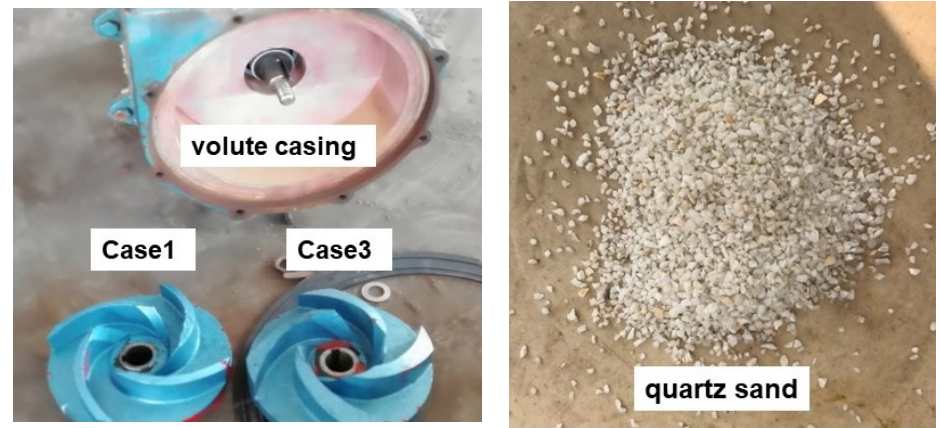
Figure 7. Manufactured impellers and abradant.